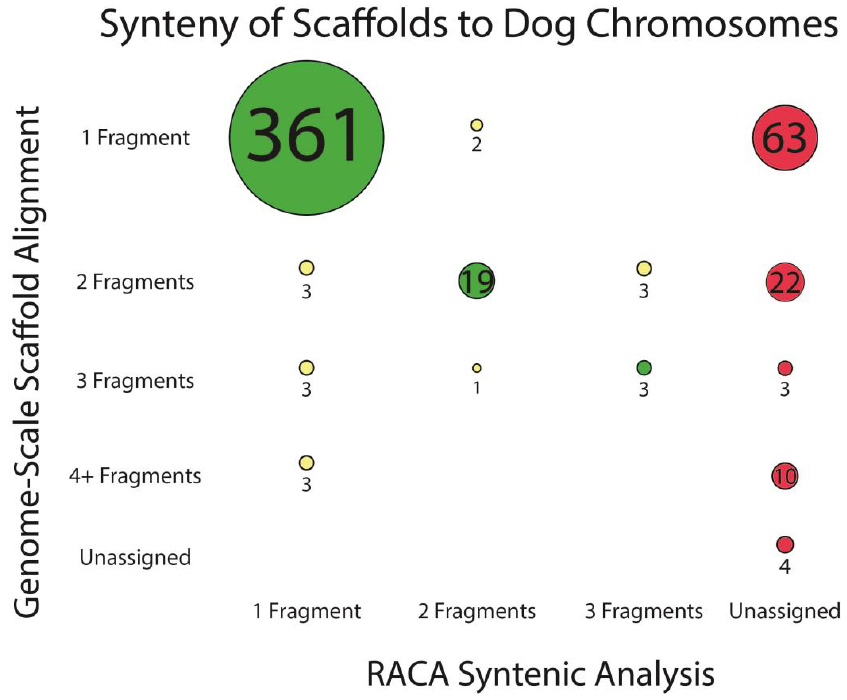
Figure 2. The number of distinct dog chromosomes syntenic to each scaffold, as predicted with two complementary methods: genome-scale alignment to identify syntenic dog chromosome(s) for each scaffold [12], and the number of dog chromosomes syntenic to each scaffold as identified by RACA. Circle diameter is proportional to the number of scaffolds, which is presented inside of or beside the circle. Green indicates that the same number of syntenic chromosomes was predicted by both methods; yellow that the methods predicted different numbers; and red that the scaffolds were excluded from the RACA assembly. Unlike the prior analysis, RACA did not compare the scaffolds to the dog Y-chromosome.